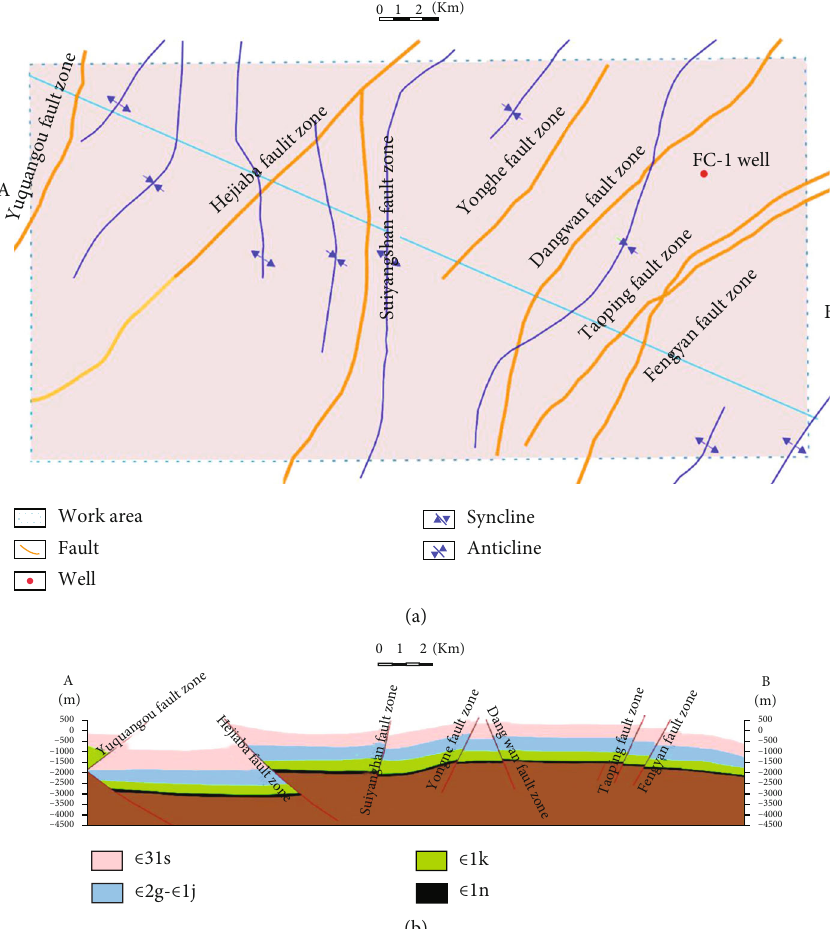
Figure 2: Geological formations in the study area. (a) Geological structural section view of the Feng ’ gang No. 3 block. (b) Basic structural feature map of the Feng ’ gang No. 3 block